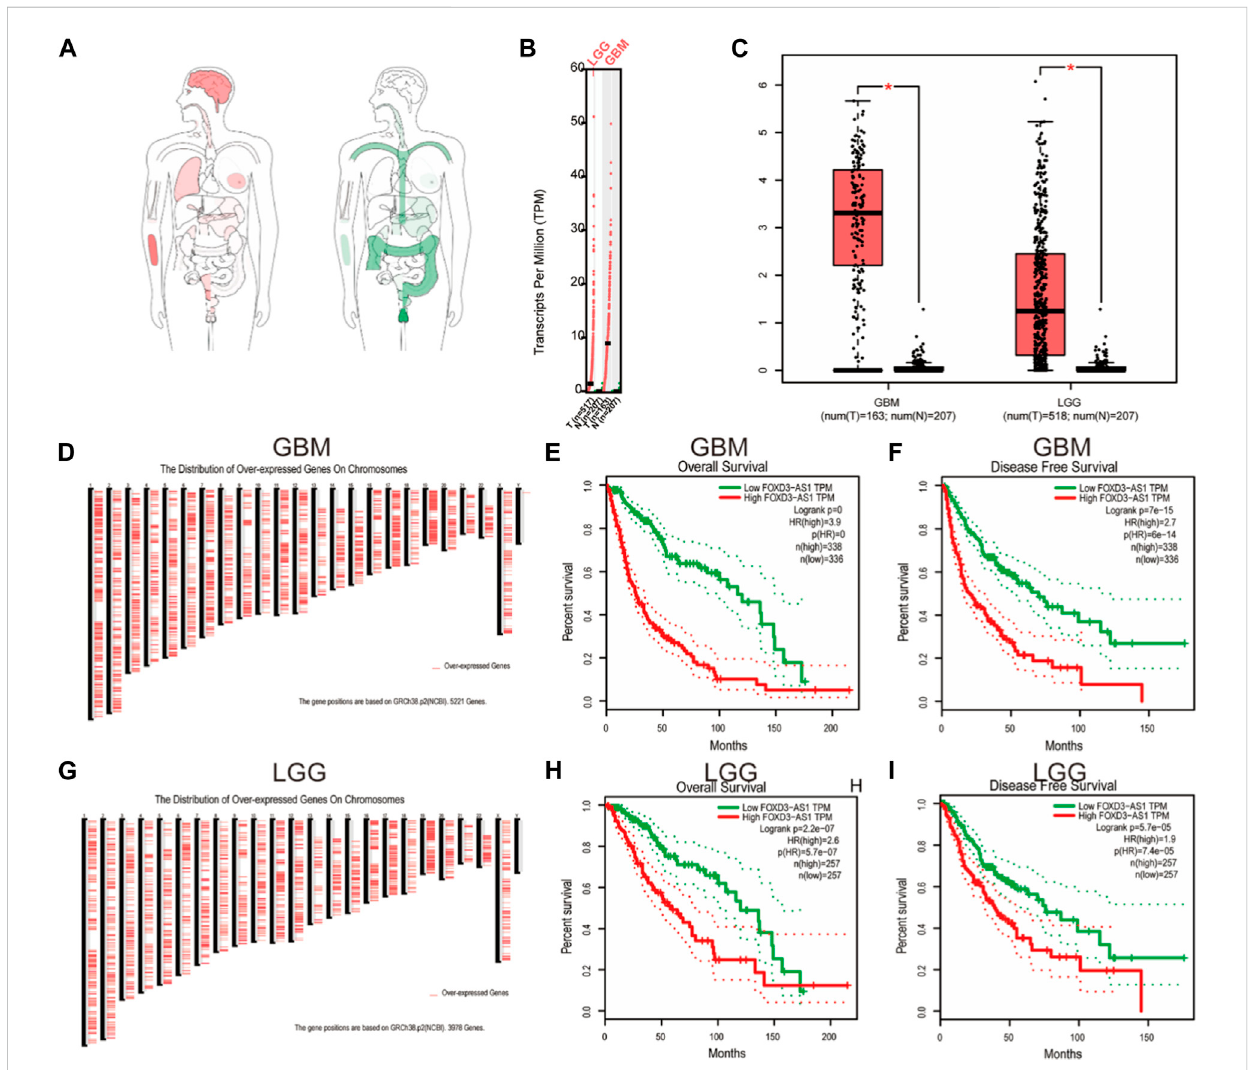
FIGURE 4 DifferentialexpressionofFOXD3-AS1inGBMandLGG. (A) InteractiveBodymapshowsthemedianexpressionoftumortissueandnormaltissue; (B) FOXD3-AS1 expression in GBM and LGG; (C) Differential expression FOXD3-AS1 of paired samples in TCGA database; (D) NCBI database is based on the location of GRCh38.p2 on chromosomes of 5221 overexpression genes in GBM; (E, F) GEPIA was used to analyze the survival curves of FOXD3-AS1 in GBM samples; (G) NCBI database is based on the location of GRCh38.p2 on chromosomes of 3978 overexpression genes in LGG; (H, I) GEPIA was used to analyze the levels of survival curves of FOXD3-AS1 expressed in GBM